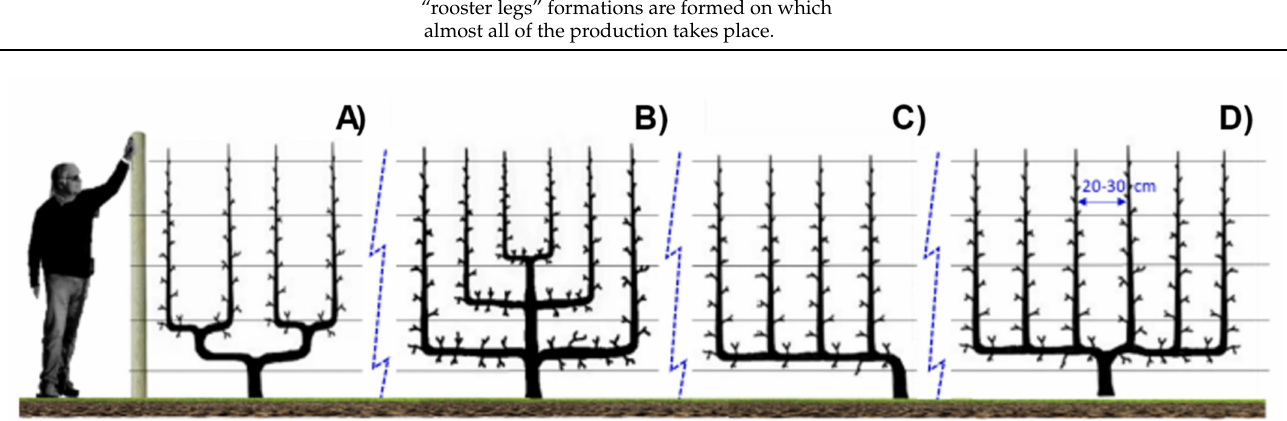
Figure 5. Two options of Candelabro system ( A , B ) and two options of multileader system ( C , D ) in pear. The multileader or planar cordon systems can be considered as an evolution of the Candelabro training system. In the last ten years, multileader systems have been tested in several species, such as apple, peach, cherry, and plum [42,54,55]. The main objective of this system is to change the traditional architecture of the canopy based on axial structures bent horizontally, on which the leaders are inserted directly at a distance ranging from very narrow canopy and reducing the planting density. Two options are developed: tall orchards and pedestrian orchards, depending mainly on the rootstock and spacing